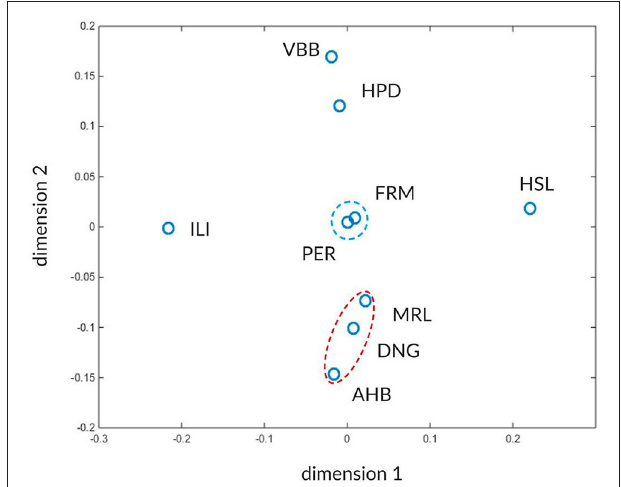
FIGURE 10 | Visualization of inter-atlas relationships using multi-dimensional scaling. The atlases are shown in a 2-D landscape computed from distances derived from the W max and W asym values ( Tables 2B,C ). Atlases that can mutually be better predicted from each other and share similar asymmetry values reside closer in this space. The two recognizable clusters are indicated by red and blue dashed ellipsoids. The arbitrary dimensions one and two give coordinates for the projected atlas similarity values in the 2D